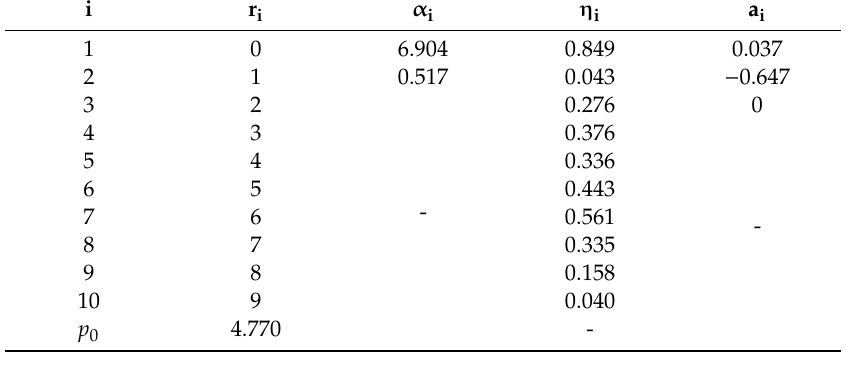
Table 4. The identified parameters of PMPI model.